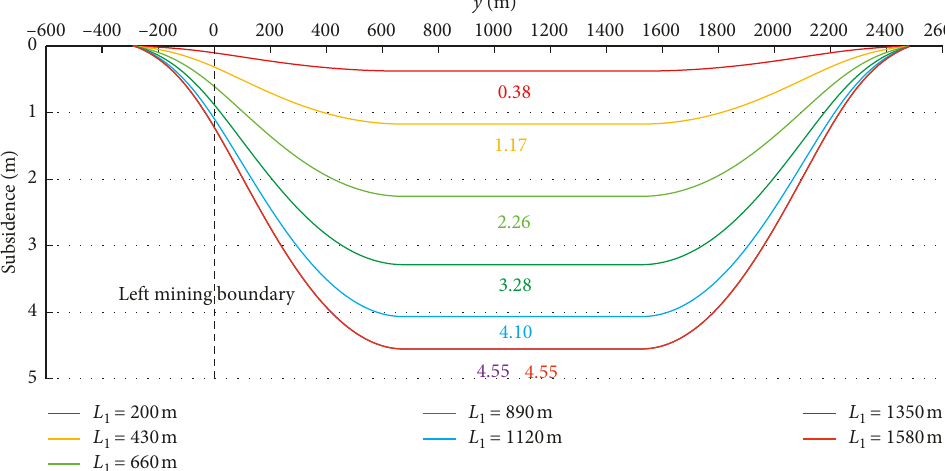
Figure 7: Subsidence curves of main section II when taking different mining dimensions of main section